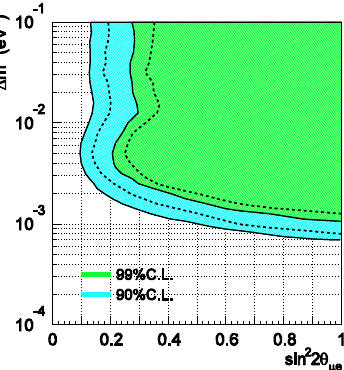
Fig. 38 Excluded region of ν e appearance in K2K. The total observed number of electron appearance candidates is 1 with 1.7 expected background mainly from high energy neutrinos. The upper limit of sin 2 2 θ μ e < 0 . 13 at 90% CL with (cid:17) m 2 = 2 . 8 × 10 − 3 eV